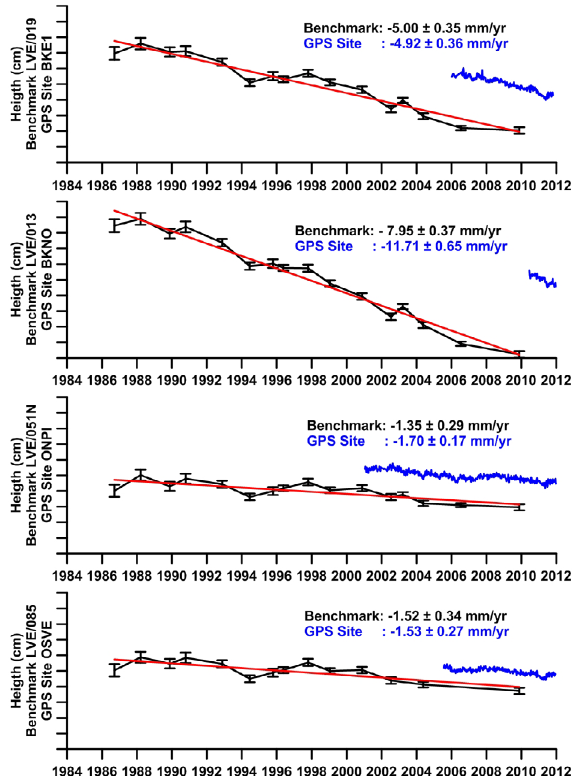
Figure 5. Time series of leveling benchmarks closest to GPS stations and comparison between benchmark and GPS velocities. Red line show linear fit of leveling data. The offset between each couple of time series is arbitrary. The Y scale is linear and spacing tick is of 2 cm.